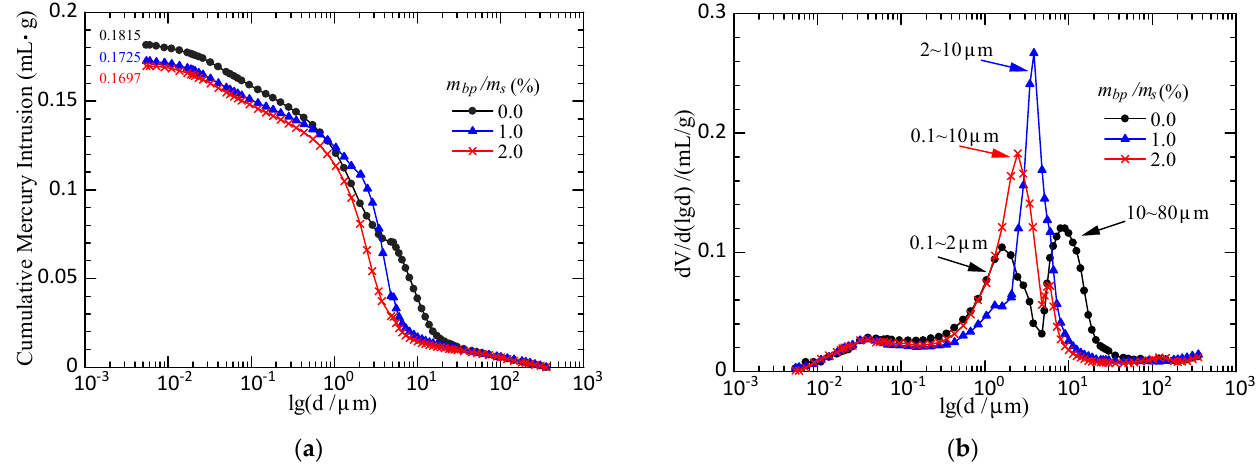
Figure 12. Mercury intrusion pore size distribution: ( a ) cumulative curves; ( b ) differential curves.